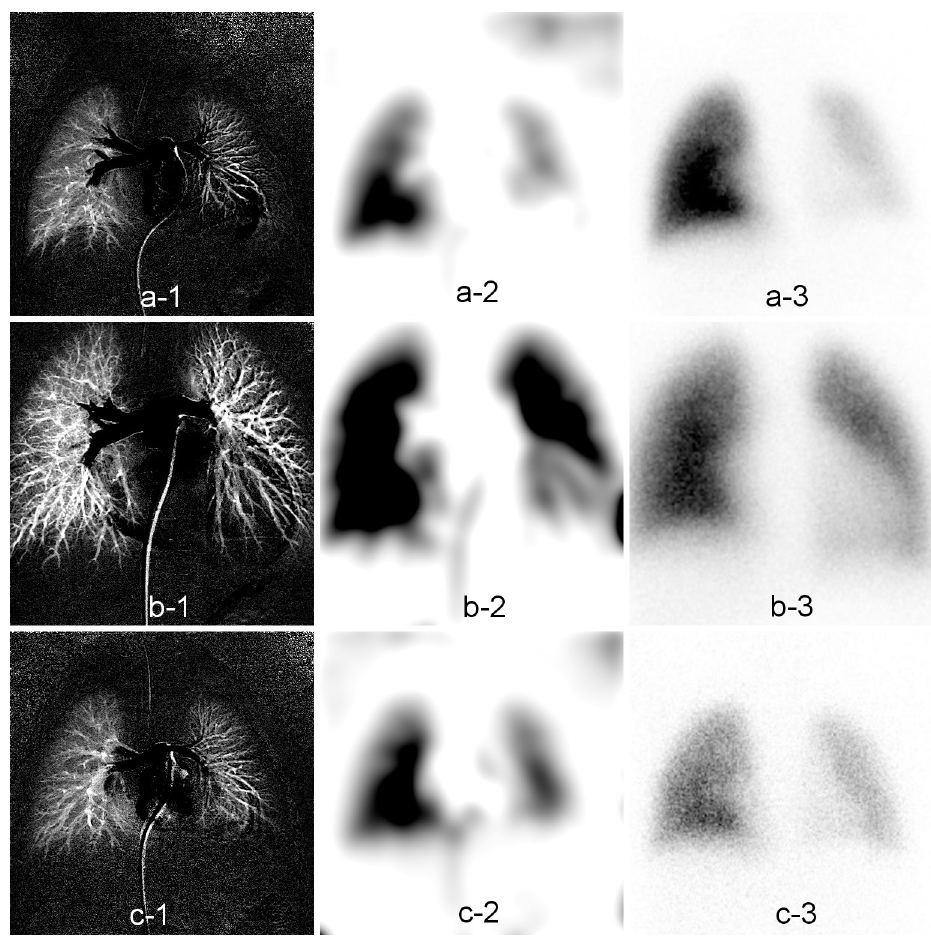
Fig 8. Comparison between X-ray pulmonary angiography (XA) and lung perfusion scintigraphy (LS) images for three representative patients. The net increase in signal intensity by XA is demonstrated in the left column (a-1, b-1, c-1). The images in the middle column are the XA images after grayscale inversion and blurring by Gaussian filtration (a-2, b-2, c-2). The images in the right column were obtained with lung scintigraphy (a-3, b-3, c-3).